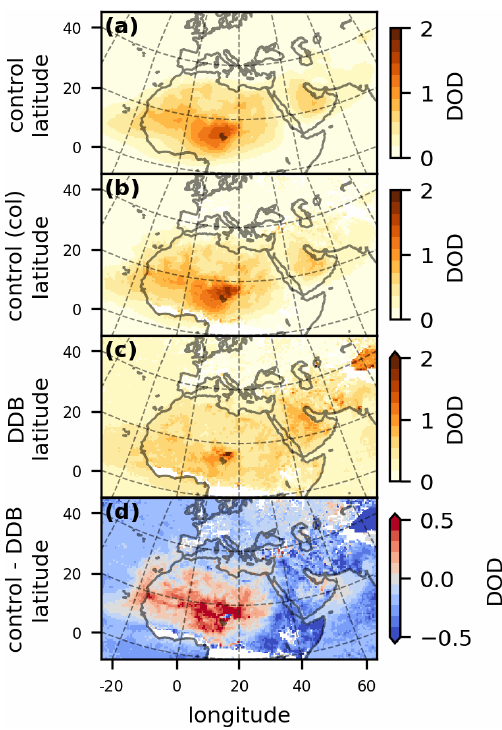
Figure 2. Averaged DOD from the control run and DDB during the whole study period. Panel (a) shows the average of the control run DOD. Panel (b) shows the average of the control run DOD in the pixels collocated with DDB. Panel (c) shows the average of the DDB DOD. Panel (d) shows the average difference between the control run and the DDB